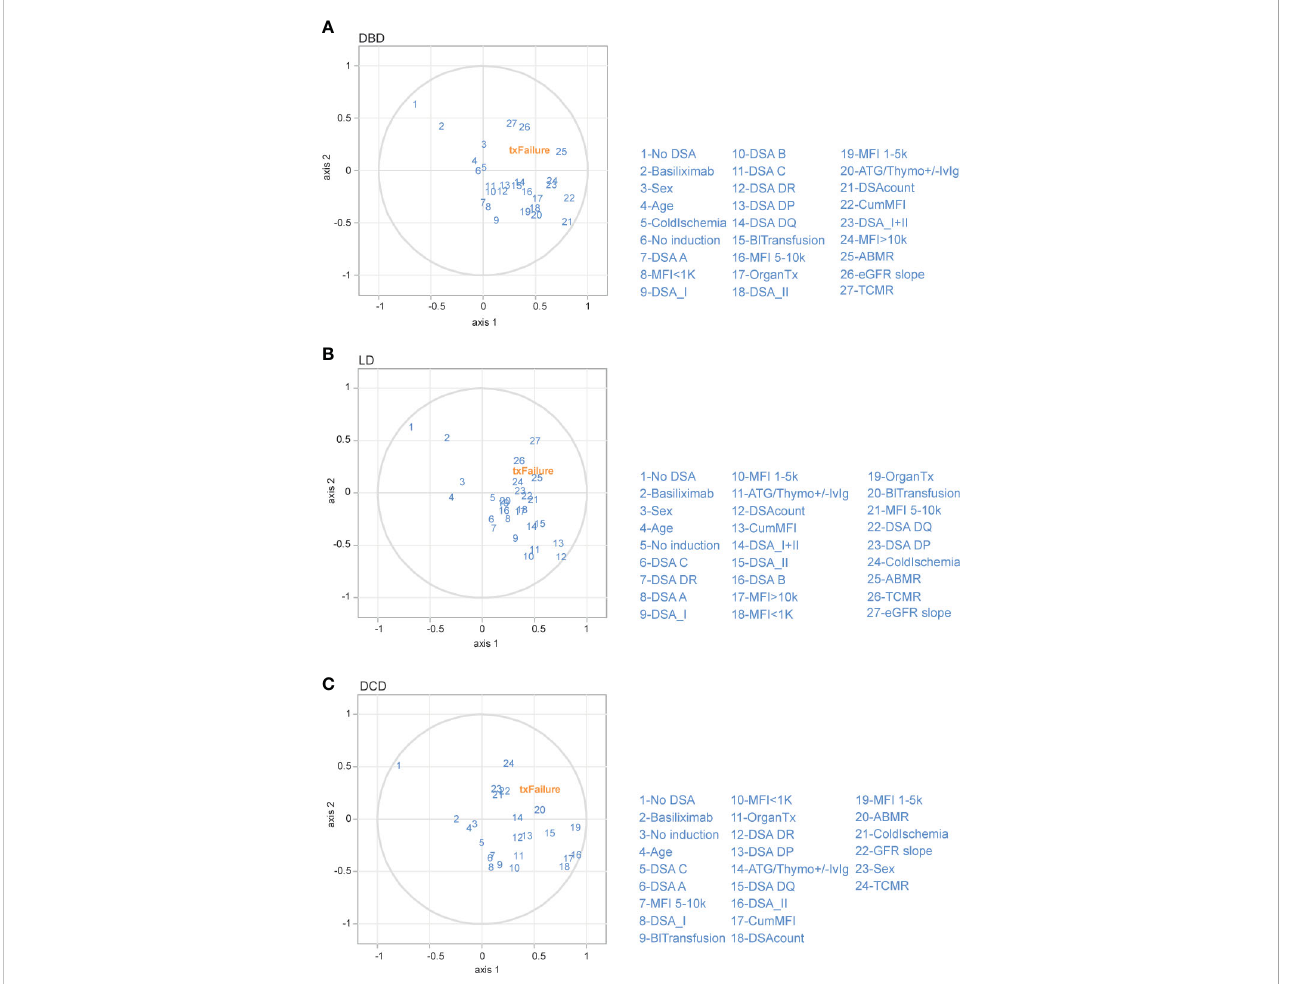
FIGURE 7 Partial least squares (PLS) regression exploratory biplot for the fi rst two components describing the correlation among different immunological risk factors to graft loss in the different donation types. Correlation shown between graft loss (txFailure) and the risk factors (in blue numbers) for DBD (A) , LD (B) and DCD (C) transplants. The fi rst two axes which correspond to PLS components 1 and 2 are shown. The distance between the individual risk factors and the center indicates the strength of the correlation with each component and their alignments represent the correlation they contribute to the variation explained by each component. (OrganTx, Organ Transplantation; BlTransfusion, Blood Transfusion; DSAcount, Number of